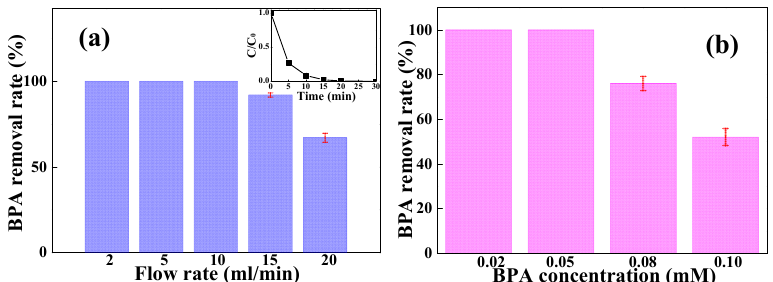
Figure 4. Impact of ( a ) solution flow rate (inset: catalytic performance of ZIF-67(Co) (0.2 g/L) toward BPA (0.02 mM) degradation) and ( b ) BPA concentration on the catalytic performance of ZFP.